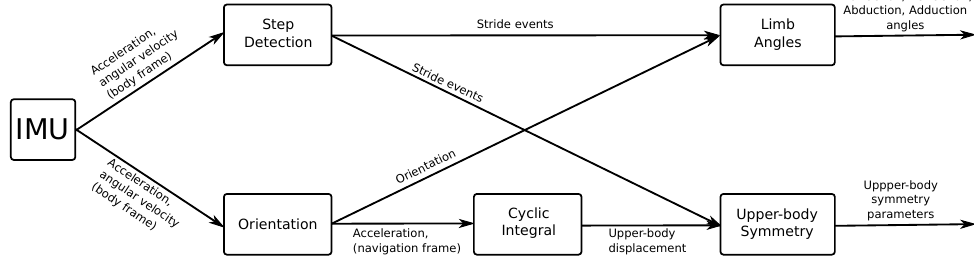
Figure 7. The EquiMoves motion processing